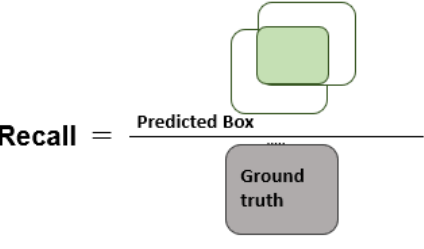
Figure 6 . Visual description of recall metric .